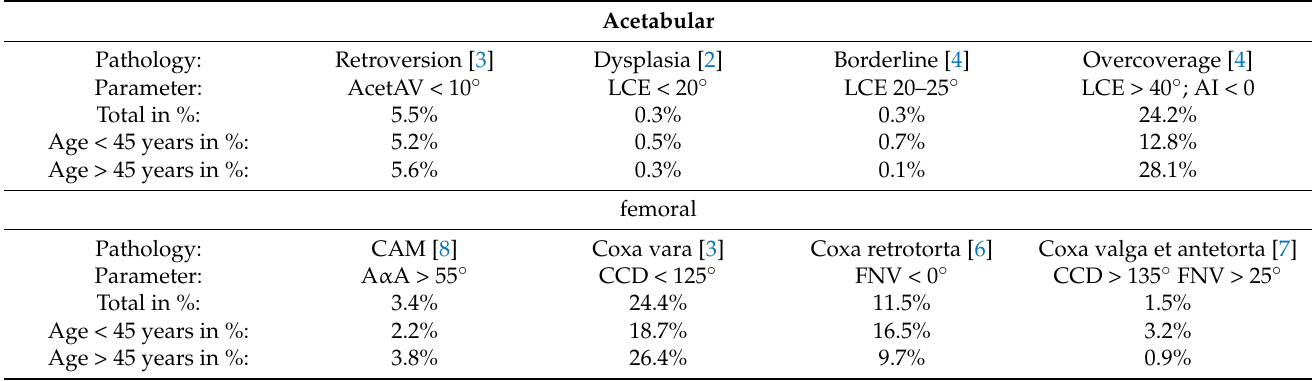
Table 4. Prevalence of morphological aberrations as precursors of osteoarthritis.